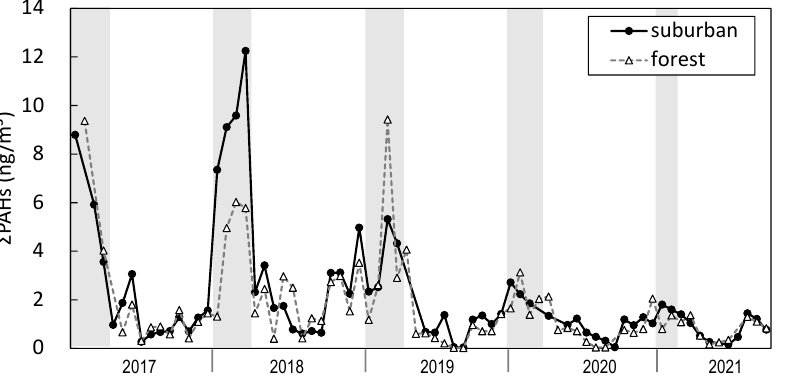
Figure 6. Total PAH concentrations ( Σ PAHs) in the suburban and forest sites of Nagasaki from 2017 to 2021. The gray areas indicate winter data. The average values for each year are shown in Figure 7 to clarify the changes over time. There was an overall decreasing behavior, although ΣPAHs increased from 2017 to 2018 at both sites. During the entire period, Σ PAHs decreased by 60% in suburban site and by 57% in forest site. There are few reports on atmospheric PAH concentrations dur- ing the same period as this study. Zhang et al. reported a 40 – 50% decrease in atmospheric PAH concentrations in Wajima, Japan, during the COVID-19 outbreak period compared to the same period of the previous year [24]. Although the study period was different, the results of this study were similar to the report.